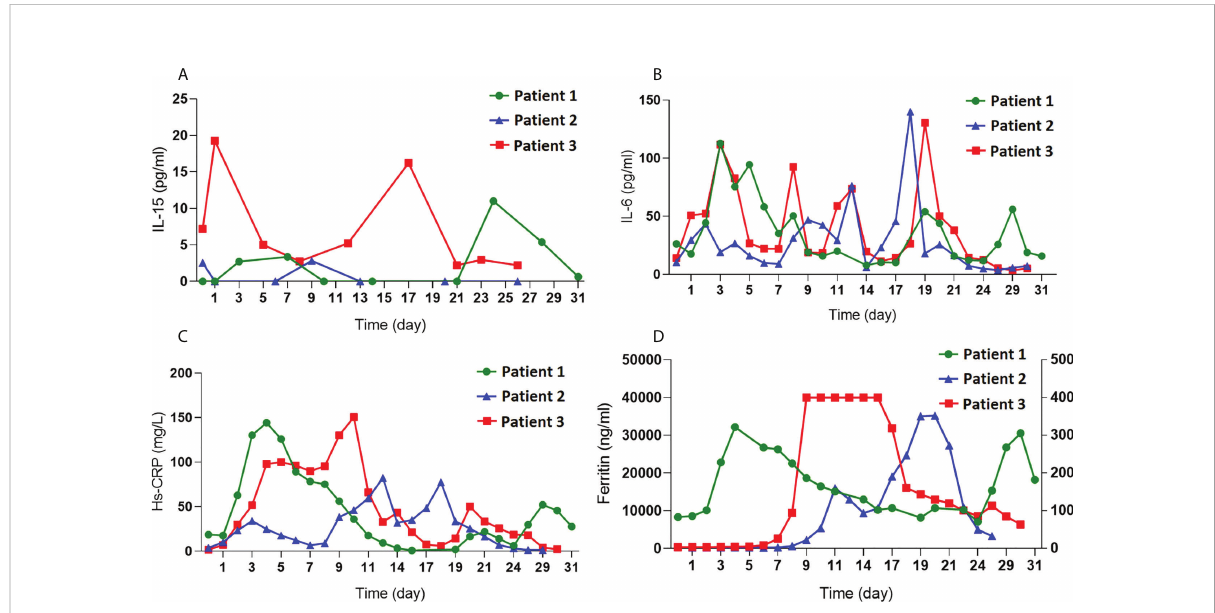
FIGURE 7 Measurement of cytokines and acute phase reactants after CD4-IL15/IL15sushi CAR T cell infusion. (A) Measurement of IL-15, (B) IL-6, (C) Hs- CRP, and (D) ferritin in the blood of all three patients demonstrate low levels of IL-15 despite secretion of IL15/IL15sushi complex from CD4- IL15/IL15sushi CAR T cells and demonstrate transient, mild increases in acute phase